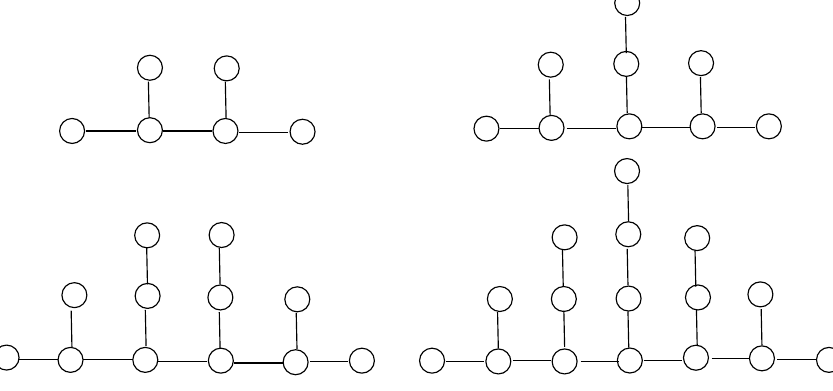
Figure 11: The trees ˜ T